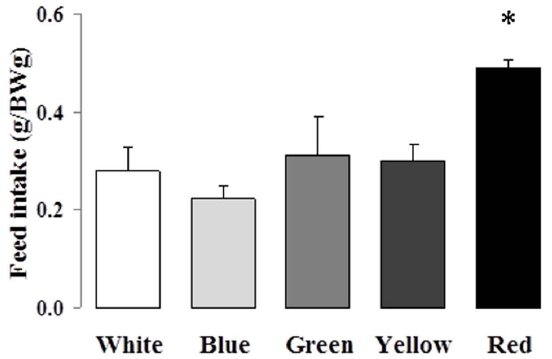
Figure 3. Mean ( ± SEM) feed intake of Nile tilapia by each color treatment. N =6, except for yellow N =5. Asterisk indicates higher mean compared to the other color treatments (not different among themselves). ANOVA, P , 0.01.